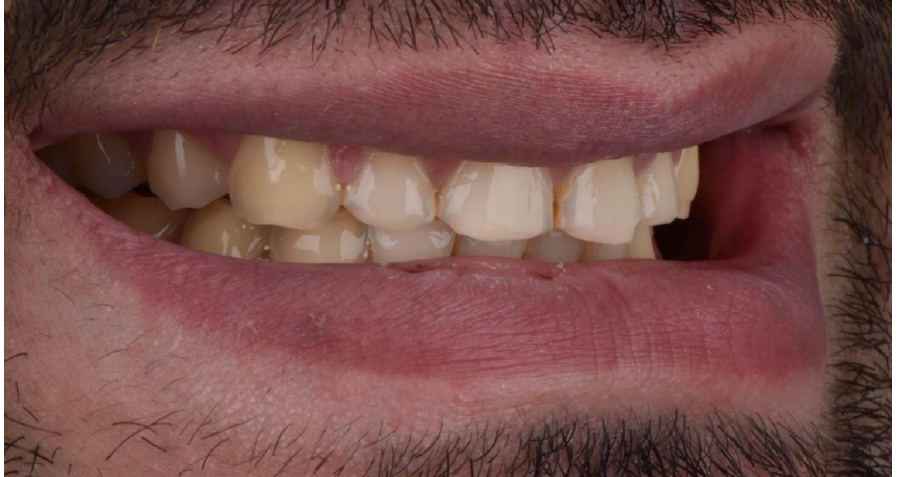
Figure 3. Extraoral smile picture (right).